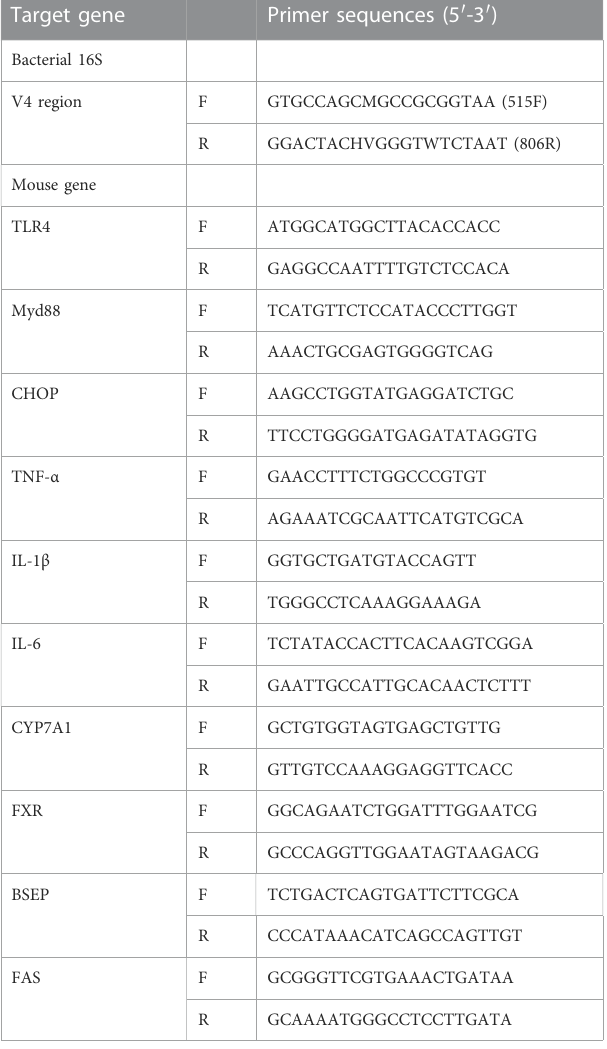
TABLE 1 Primer sequences for quanti fi cation of the following target